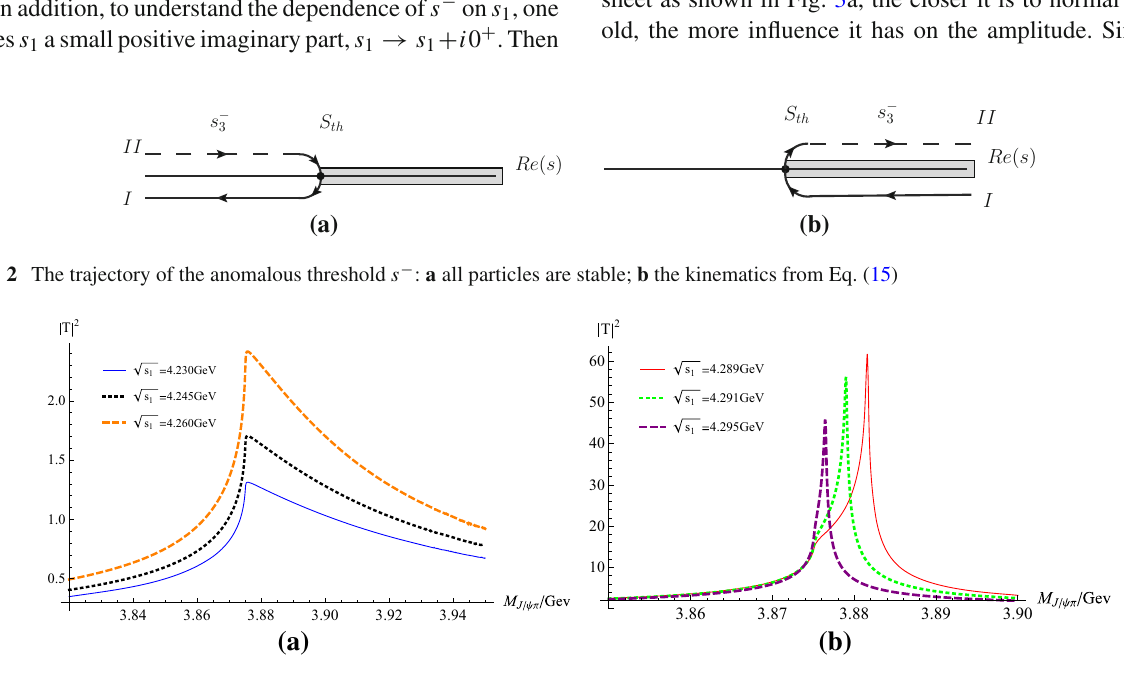
Fig. 3 Invariant mass distributions of the process X ( 4260 ) → ππ J /ψ from the triangle diagram for different sheet; b the ATS is on the first sheet, and above the normal threshold Fig. 4 Feynman diagrams